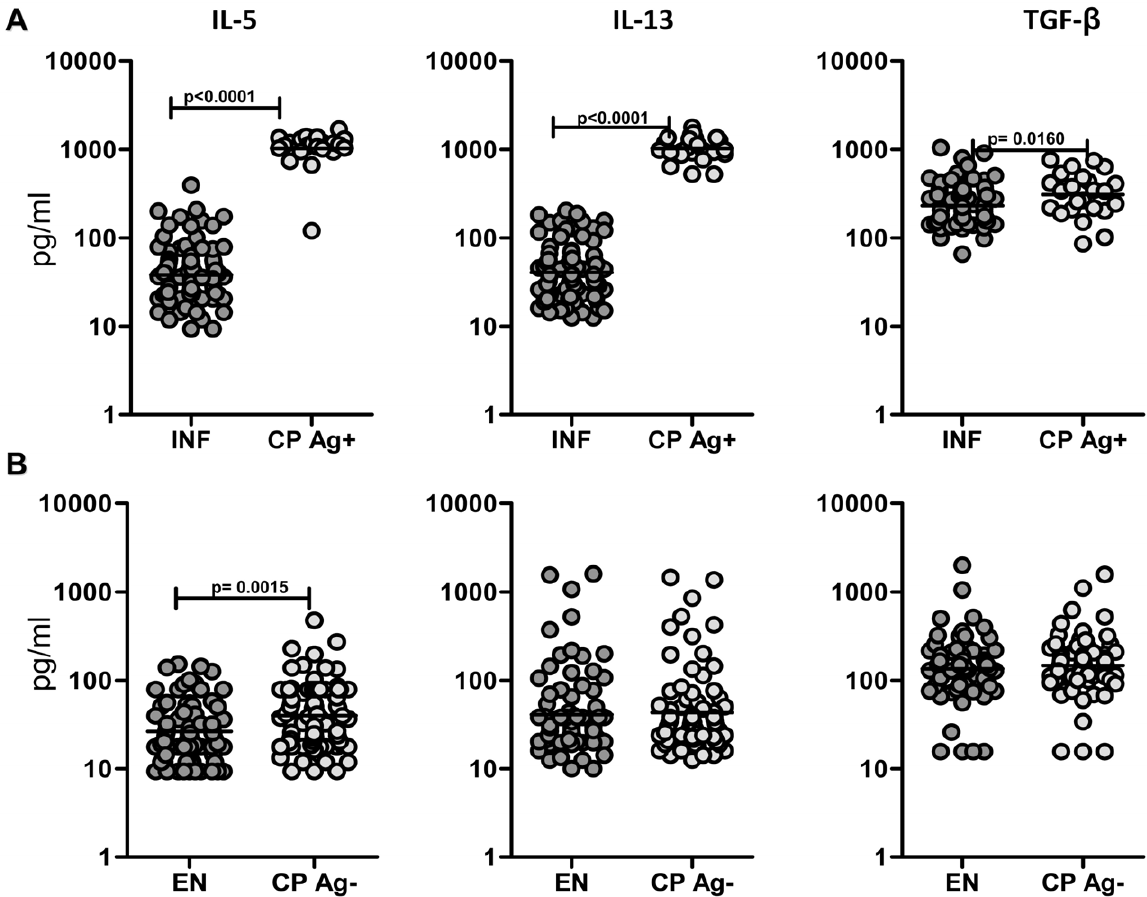
Figure 5. Circulating levels of pro-fibrotic cytokines in filarial lymphedema. (A) Plasma levels of IL-5, IL-13, and TGF- b from filarial lymphedema individuals with active infection [CP Ag + ] ( n =24) and asymptomatic infected [INF] (n=90) individuals were measured by ELISA. (B) Plasma levels of IL-5, IL-13, and TGF- b from filarial lymphedema individuals without active infection [CP Ag 2 ] (n=70–91) and endemic normal [EN] (n=68–80) individuals were measured by ELISA. P values were calculated using the Mann-Whitney test.